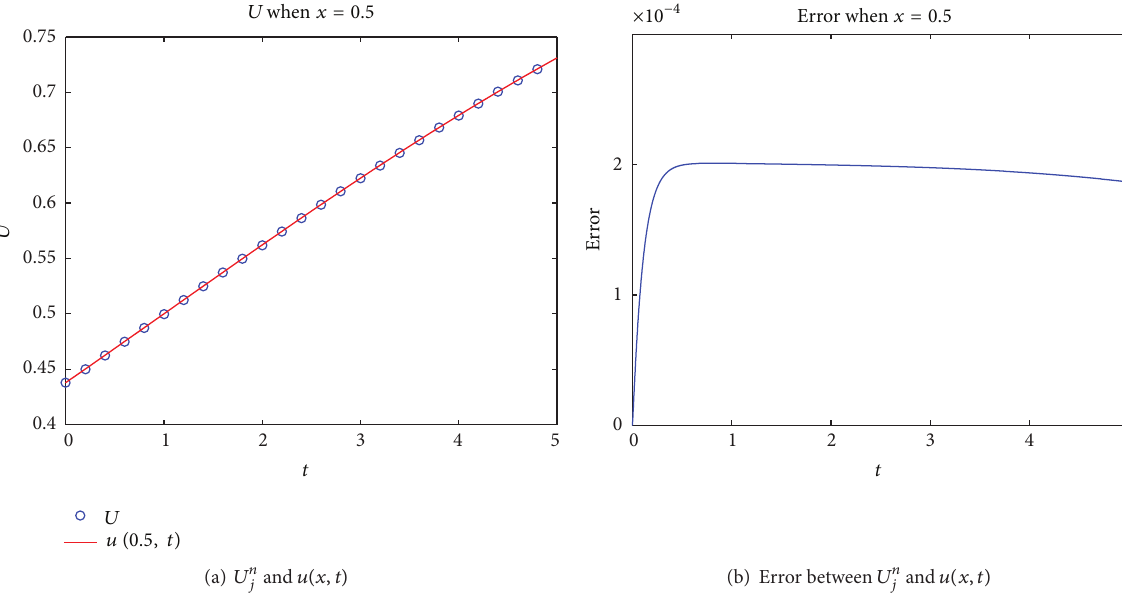
Figure 2: 𝑈 and 𝑢(𝑥,𝑡) at a fixed value 𝑥 = 𝑥 = 0.5 for NSFD scheme